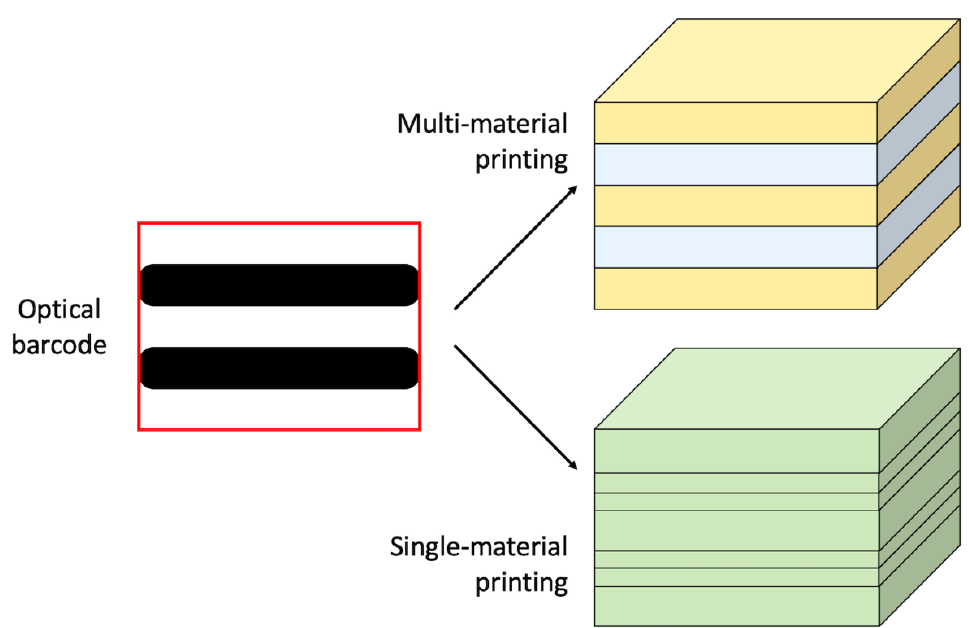
Figure 8. Schematic representation of the LayerCode strategy proposed by Maia et al. [29]. Optical barcodes are translated into 3D printed objects by alternating layers with different materials or layers with variable deposition height (resolution).